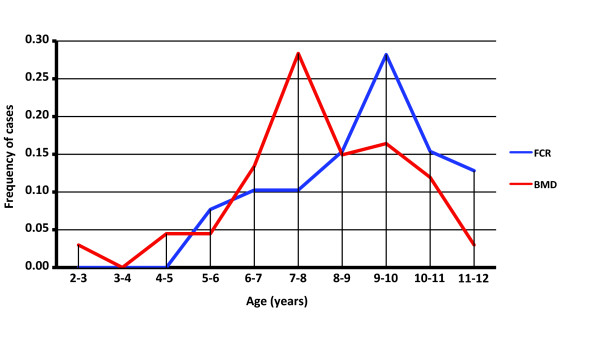
Distribution of the age of diagnosis of HS in US-resident BMD (68 cases) and FCR (45). The mean age of HS diagnosis is significantly different between BMD (7.7 yrs) and FCR (8.6 yrs) (pval = 0.01, Mann-Whitney U test).